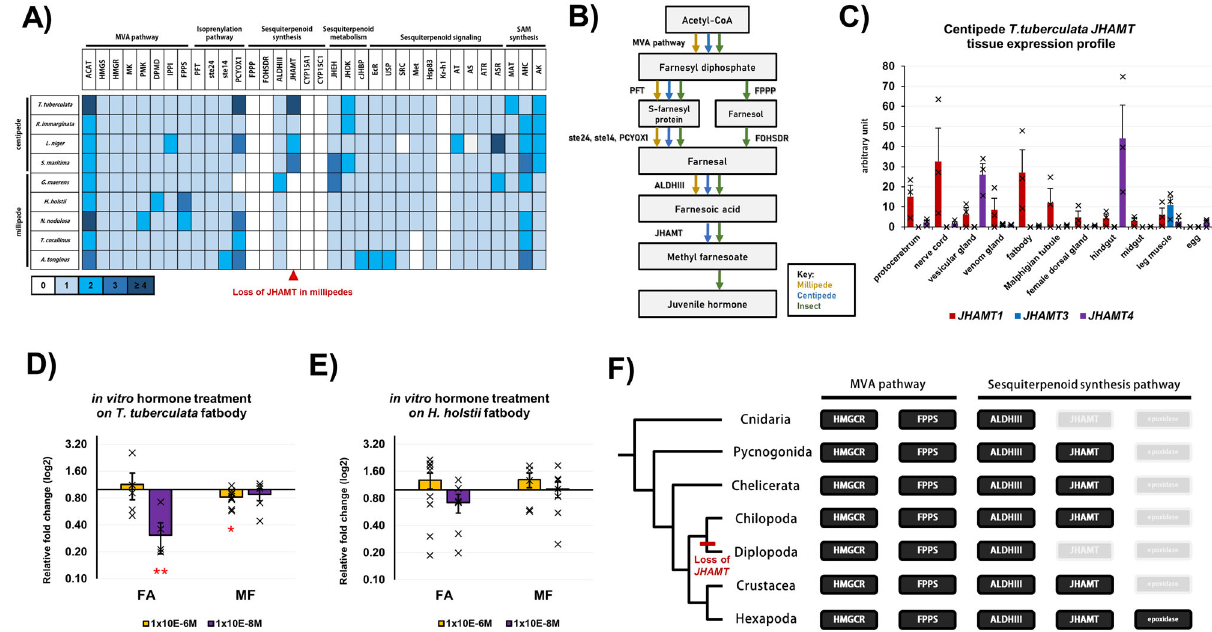
Fig. 6 Sesquiterpenoid system in myriapods. A Sesquiterpenoid pathway genes identi fi ed in sequenced myriapod genomes. B Summary diagram indicating different pathways that arthropod utilized for the synthesis of different sesquiterpenoid hormone. C The differential tissue expression of JHAMT in T. tuberculata ( n = 3 biologically independent T. tuberculata ). Data are presented as mean values + / − SEM. Individual data points are present on each bar. The vertical error bars indicate the standard error of mean (SEM) among the data points in each experiment. D The vitellogenin ( Vg ) expression in T. tuberculata fatbody ( n = 5 biologically independent T. tuberculata fatbody tissue for 10 − 6 M FA in vitro treatment, n = 5 for 10 − 8 M FA treatment, n = 9 for 10 − 6 M MF treatment, n = 5 for 10 − 8 M MF treatment) post-hormonal treatment for 4 h. Data are presented as mean values + / − SEM. Individual data points are present on each bar. The vertical error bars indicate the standard error of mean (SEM) among the data points in each experiment. Two-tailed student t -test with two sample unequal variance test was conducted with con fi dence interval at 0.95. Red asterisk indicates the P value of the test, ** ≤ 0.05 and * ≤ 0.08. The P value of 10 − 8 M FA experiment is 0.002915, while that of 10 − 6 M MF experiment is 0.07234 (as shown in the fi gure). E The Vg expression in H. holstii fatbody ( n = 9 biologically independent H. holstii fatbody tissue for 10 − 6 M FA in vitro treatment, n = 6 for 10 − 8 M FA treatment, n = 6 for 10 − 6 M MF treatment, n = 7 for 10 − 8 M MF treatment) post-hormonal treatment for 4 h. Data are presented as mean values + / − SEM. Individual data points are present on each bar. The vertical error bars indicate the standard error of mean (SEM) among the data points in each experiment. Two- tailed student t -test with two sample unequal variance test was conducted with con fi dence interval at 0.95. F Summary indicating the evolution of sesquiterpenoid pathways in arthropods and